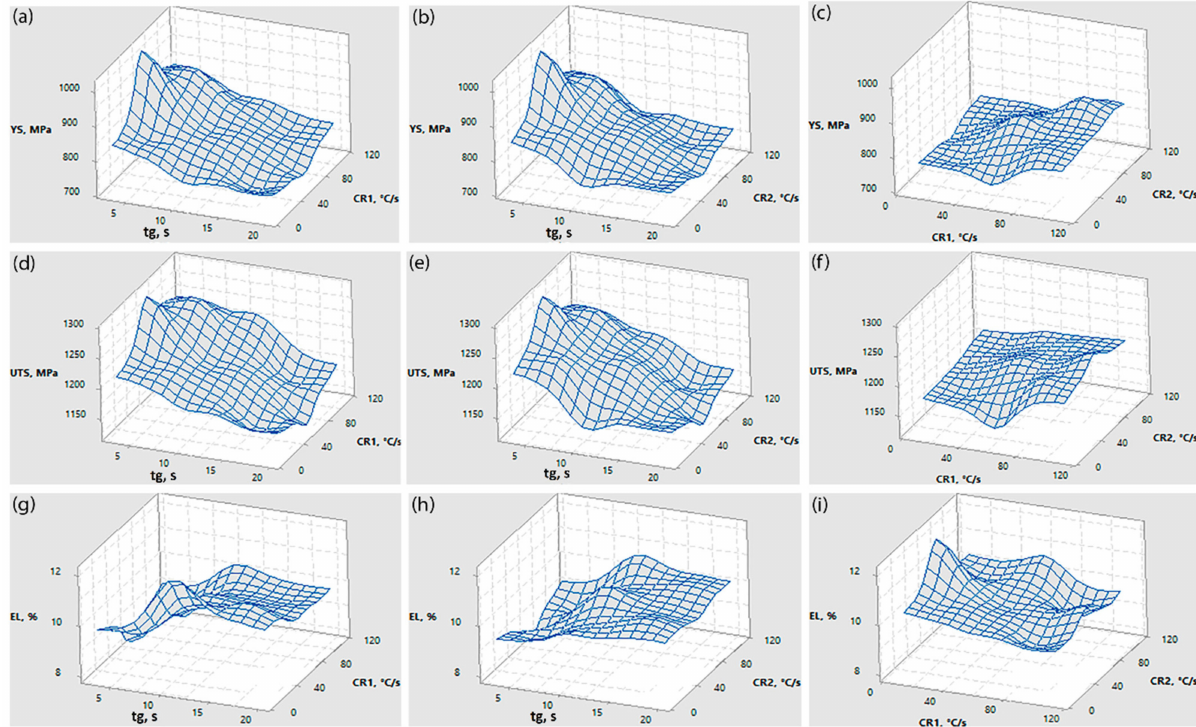
Figure 4. Relationships between yield strength ( YS ), ultimate tensile strength ( UTS ) and elongation at fracture ( EL ) and heat treatment parameters, including initial cooling rate ( CR1 ), holding time at the galvanizing temperature ( tg ) and the final cooling rate to room temperature ( CR2 ). ( a ) YS vs. tg and CR1, ( b ) YS vs. tg and CR2, ( c ) YS vs.tg CR1 and CR2, ( d ) UTS vs. tg and CR1, ( e ) UTS vs. tg and CR2, ( f ) UTS vs.tg CR1 and CR2, ( g ) EL vs. tg and CR1, ( h ) EL vs. tg and CR2, ( i ) EL vs.tg CR1 and CR2.